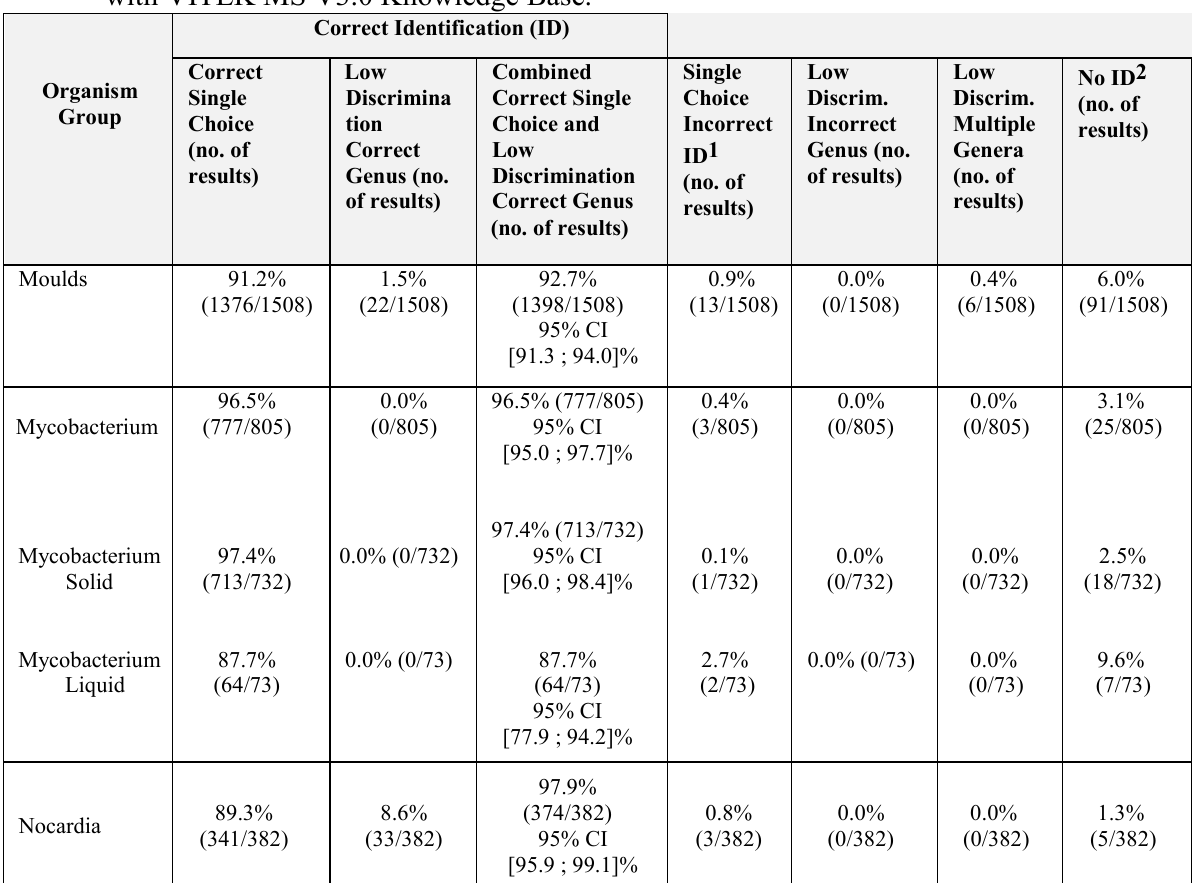
12: Overall Study Performance Results for Moulds, Mycobacteria and Nocardia with VITEK MS V3.0 Knowledge